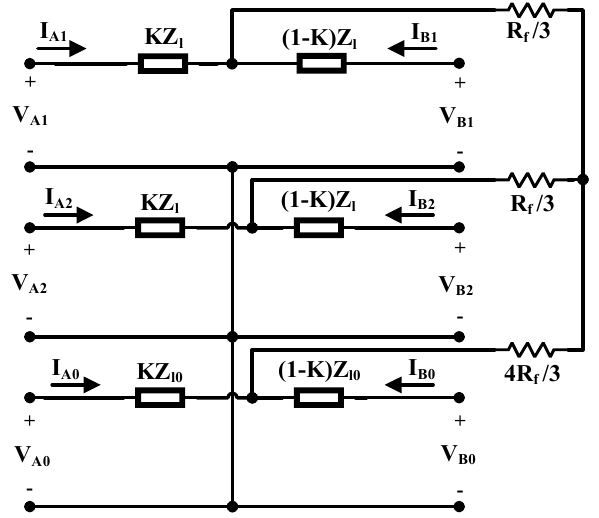
Figure 6. Sequence equivalent circuits for DLG fault.